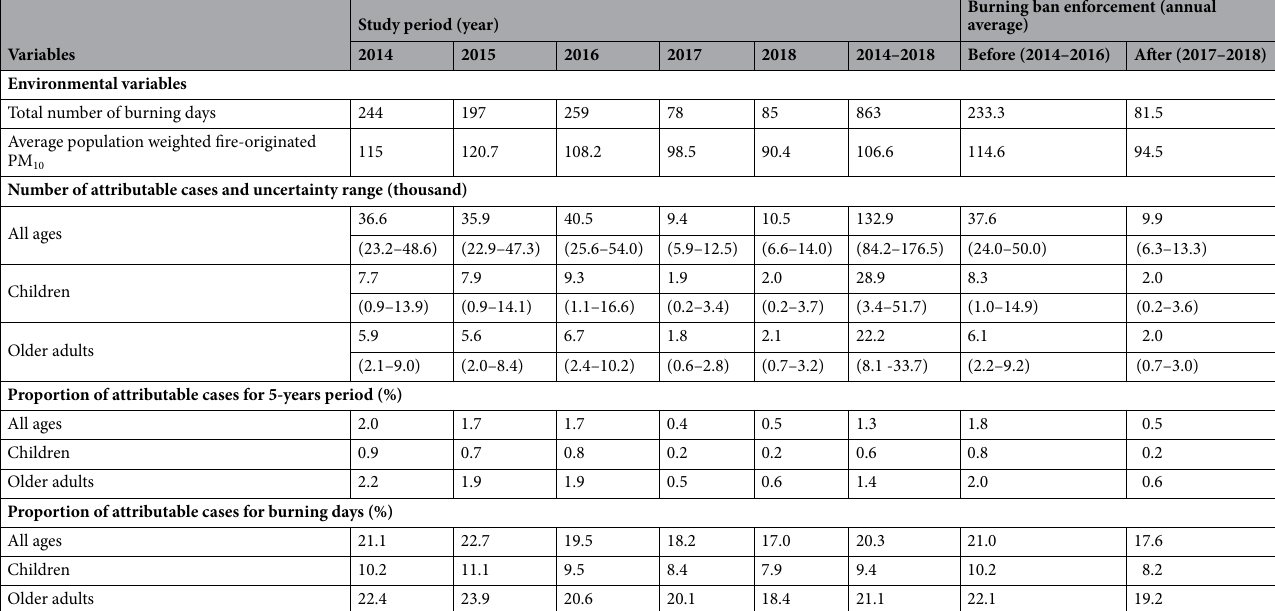
Table 2. Fire-originated PM 10 concentration and estimated number of hospital visits attributable to fire- originated PM 10 during 2014–2018 for eight